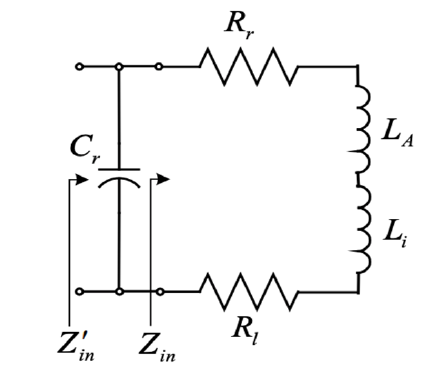
Figure 7. ( a ) Physical image ( b ) Construction of Loop Antenna.